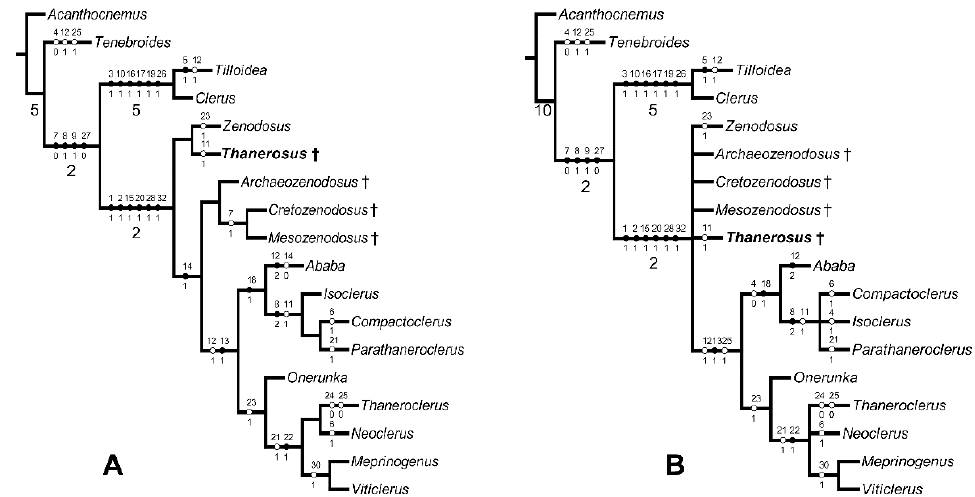
Figure 5. Phylogenetic trees with mapping of character states and Bremer support values above 1 (below lines): ( A ) single tree resulting from the analysis in which character 7 was treated as in original descriptions (mandible bidentate in Mesozenodosus and Cretozenodosus ); ( B ) strict consensus of three trees with character 7-0 (mandible unidentate) in all fossils but Cretozenodosus in which character 7 is denoted as unknown (7-?).